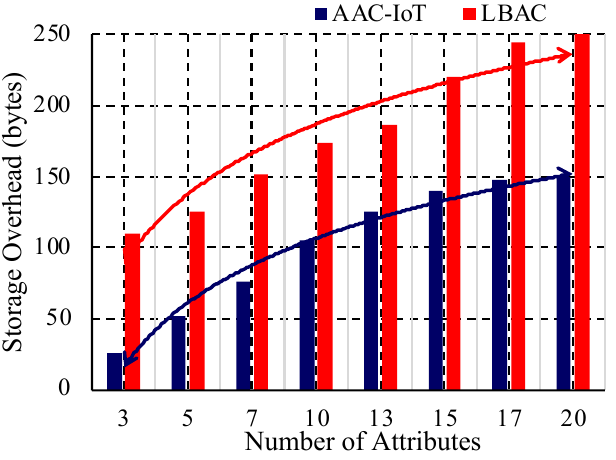
Figure 12. Performance of storage overhead plot against number of